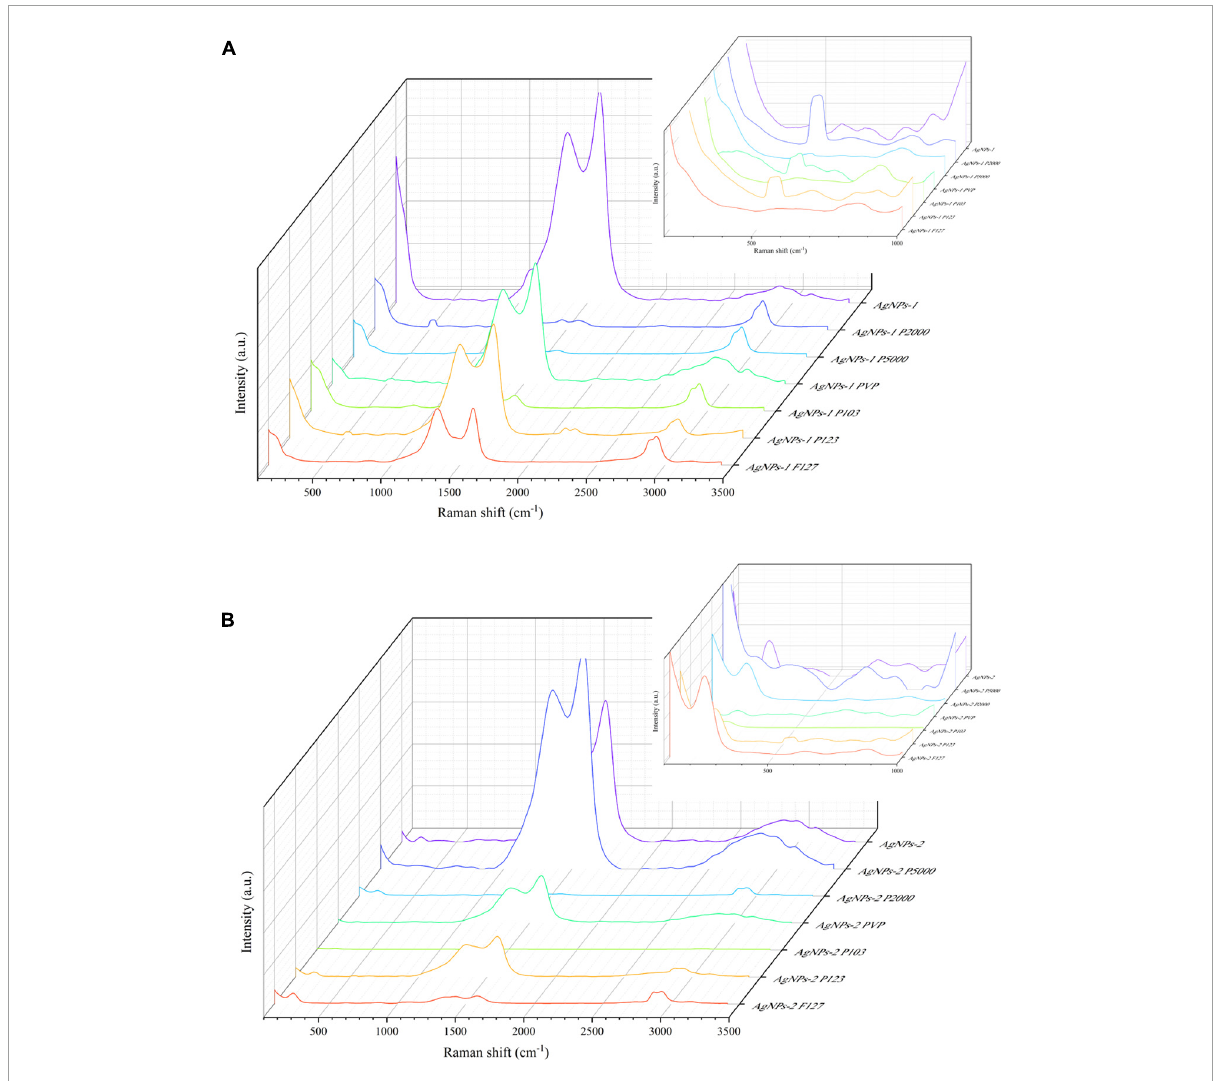
FIGURE3 Raman spectrum of AgNPs-1/2 and P-AgNPs-1/2. (A) AgNPs-1 and P-AgNPs-1. (B) AgNPs-2 and P-AgNPs-2. The inset figures are corresponding zoomed-in views at 100–1,000 cm - 1